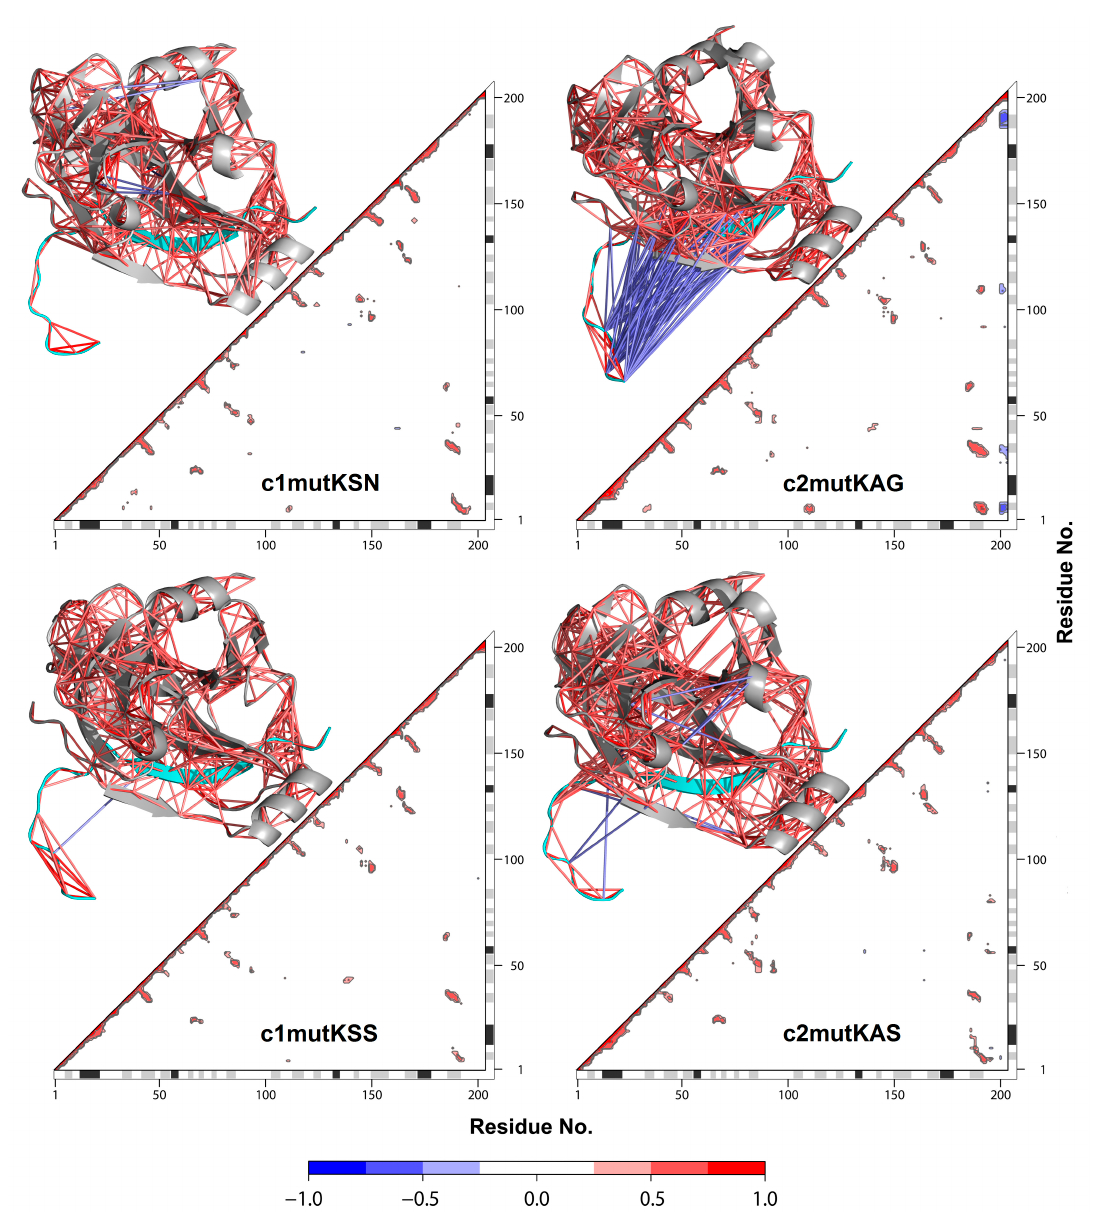
Figure 5. Dynamic cross-correlation matrix with the correlation coefficients module (| C (ij) |) > 0.4. For each matrix, the 3D structure is shown. Each value ranges from + 1.0 to − 1.0, representing a pair of amino acids being either completely correlated (red) or anticorrelated (blue), respectively. NS4A cofactor (cyan).